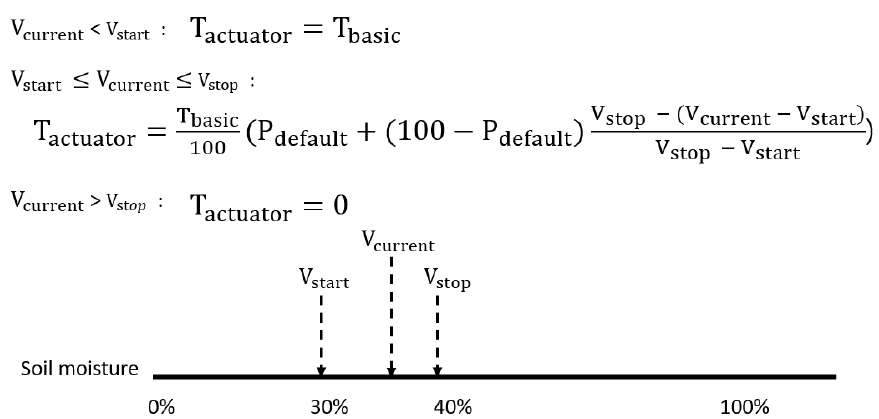
Figure 10. Actuation ratio depending on the target sensor value and the current sensor value.